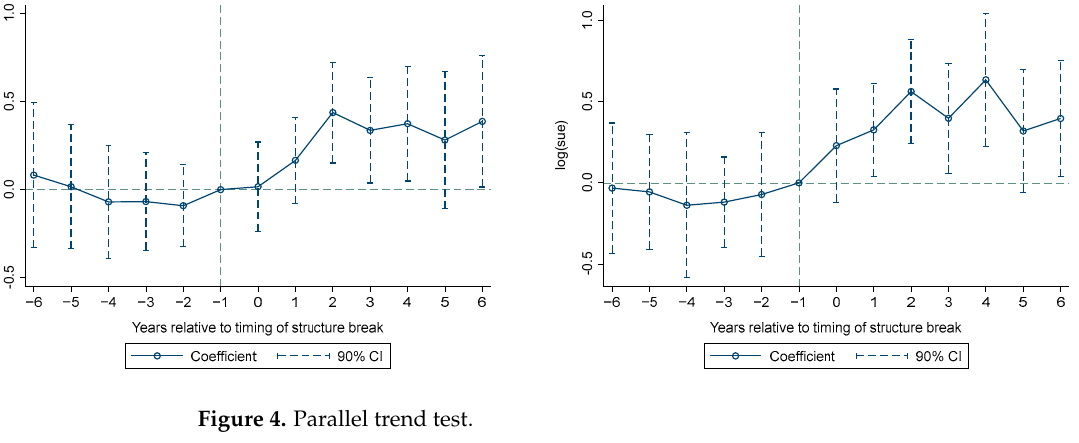
Figure 4. Parallel trend test.